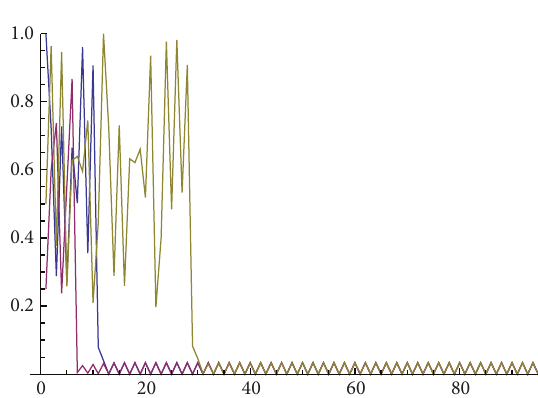
Figure 6: Topological entropy for fixed 𝛽 , 1.1 (a) and 1.15 (b) while 𝛼 ∈ [1, 2] .